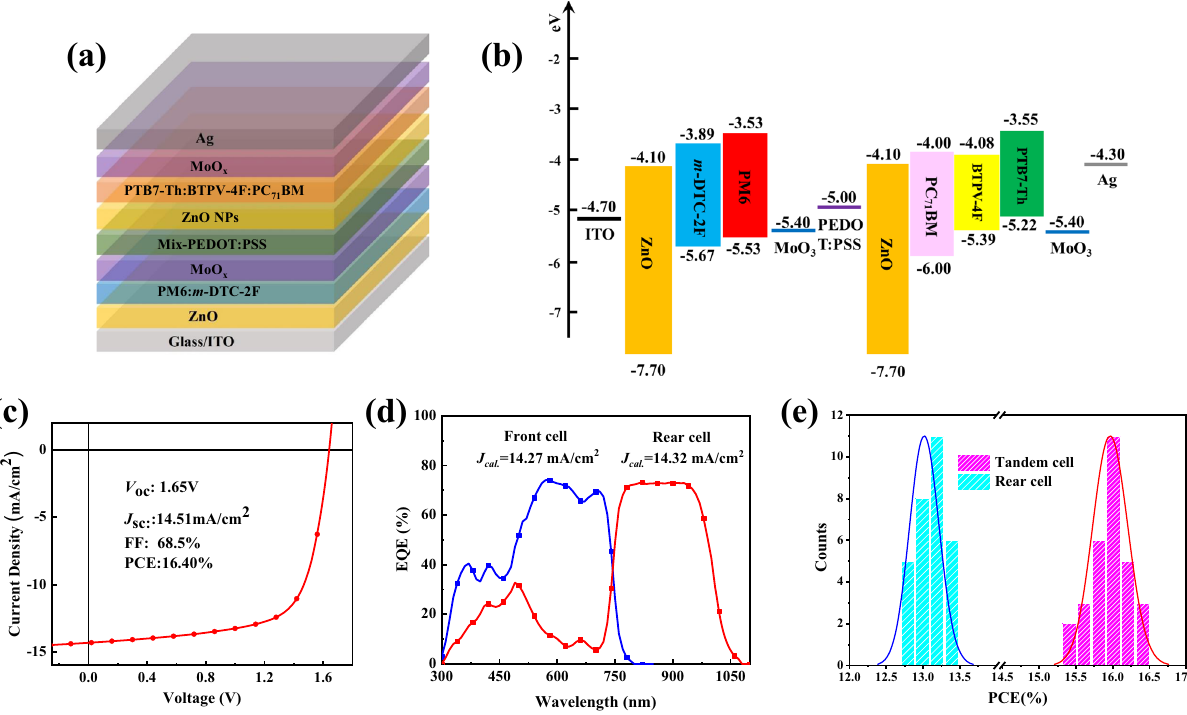
Fig. 6 Device structure and photovoltaic performance of tandem solar cells. a Device architecture of the tandem OSCs. b Energy level diagram of the related materials in the tandem OSCs. c The J – V curves of the optimal tandem OSC under the illumination of AM 1.5 G, 100 mWcm − 2 . d EQE spectra of the front and rear cells of the tandem OSC. e PCE distribution of the BTPV-4F based single-junction OSCs and tandem OSCs based on 30 individual devices. Table 2 Photovoltaic parameters of the optimal single-junction OSCs and tandem OSC.